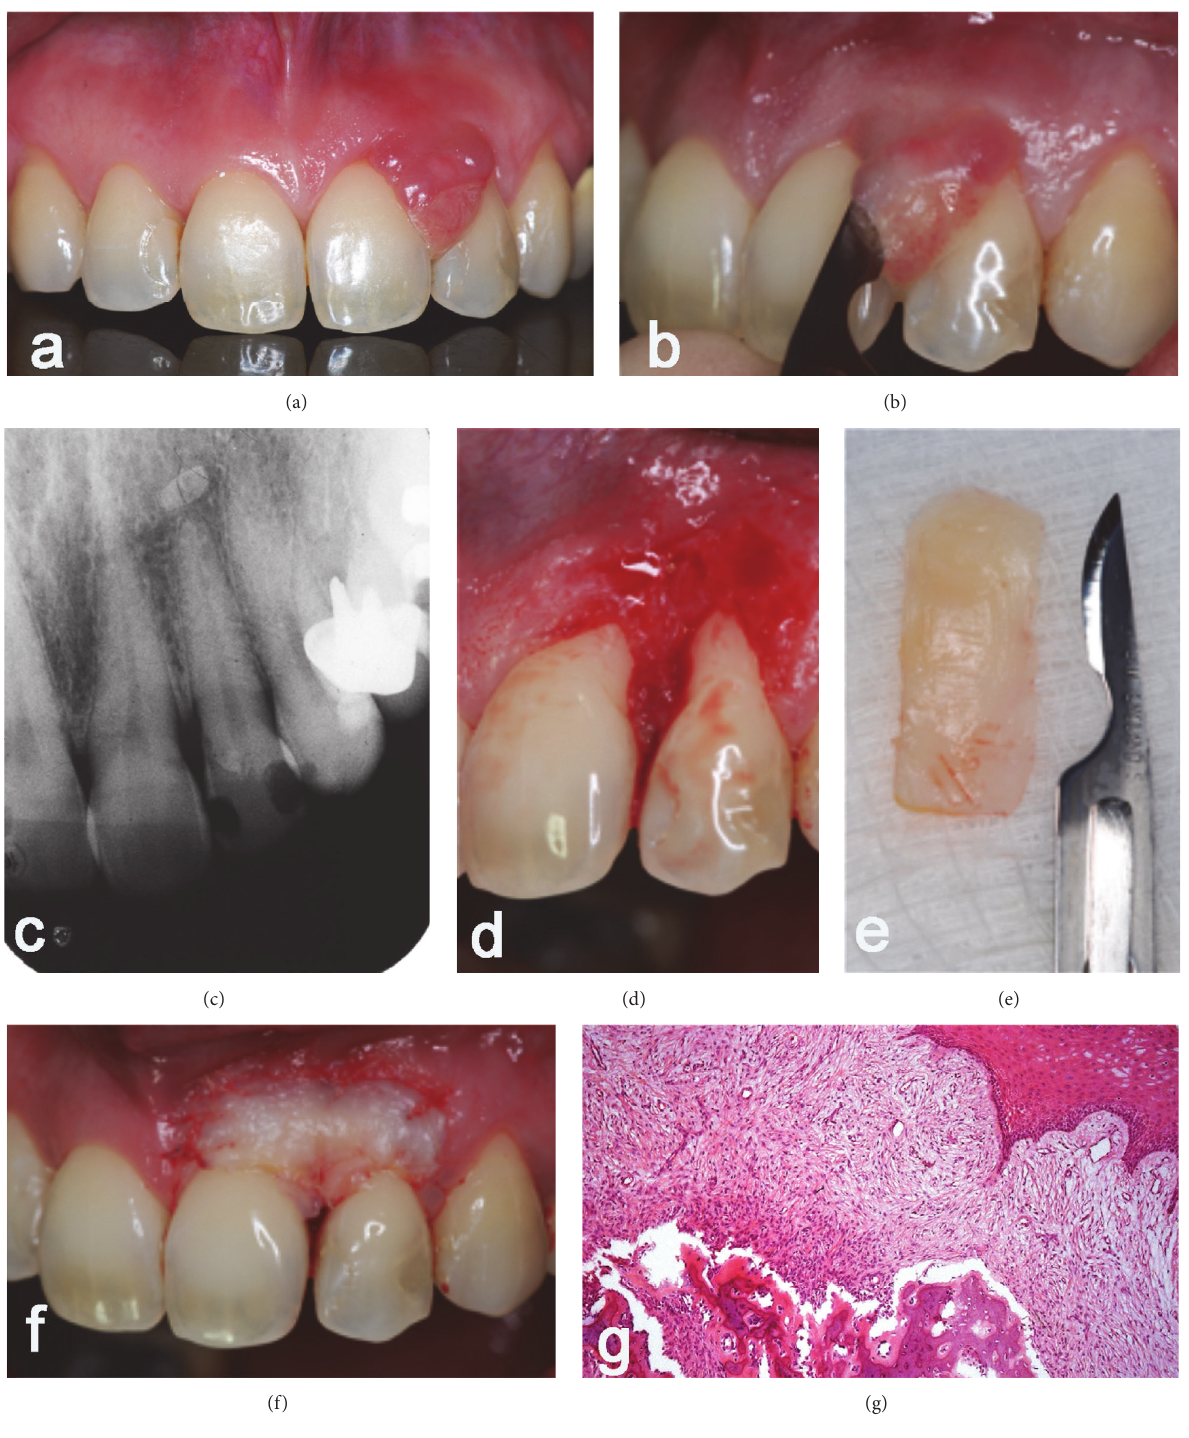
Figure 1: (a) Intraoral physical examination showed an injury inserted in the interproximal gum; ((b), (d), and (e)) excision of the lesion; (c) radiographic examination with no changes observed. (g) Histological diagnosis of peripheral ossifying fibroma.